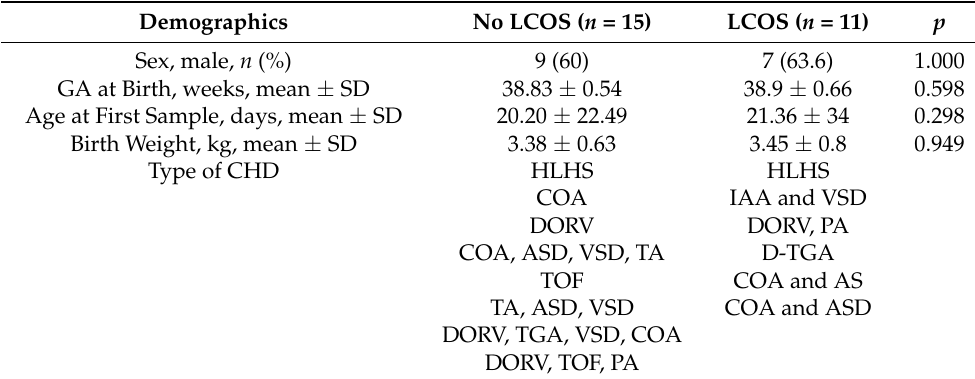
Table 2. Group 2 demographics stratified by primary